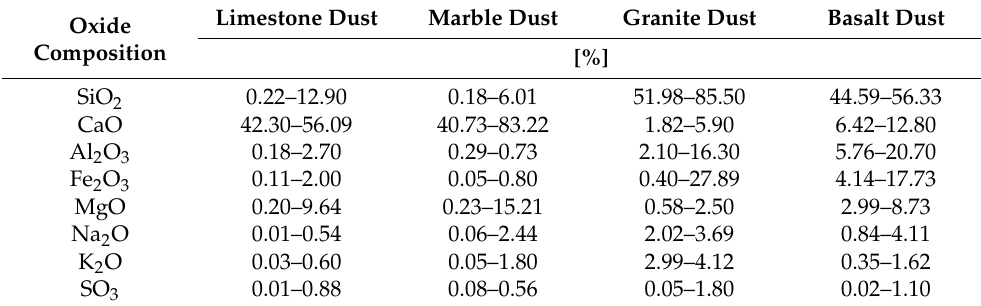
Table 1. Chemical composition of limestone [22,35,44,46,51,52], marble [30,35,38,48,53], granite [14,54], and basalt dust